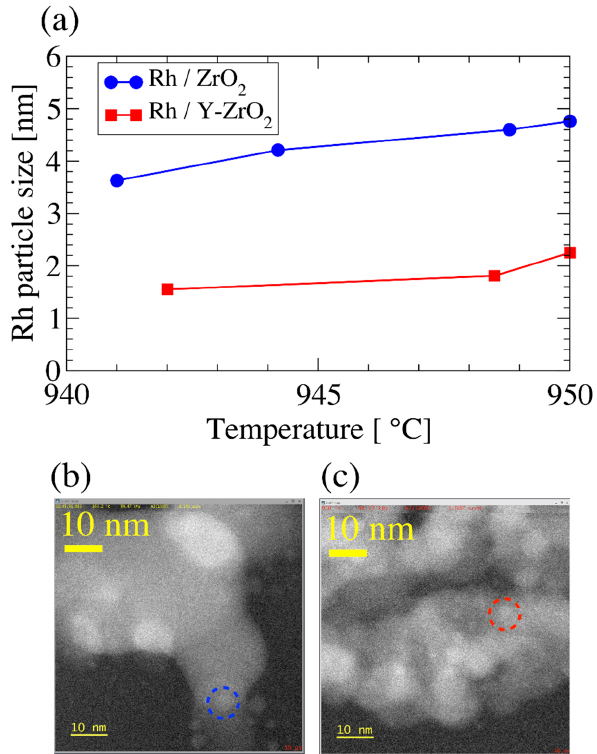
Figure 10. ( a ) Temperature dependence of the Rh particle size, which was obtained from tracking the corresponding Rh particle in the STEM images in Figures 8 and 9. ( b ) and ( c ) are STEM images of Rh/ZrO 2 and Rh/Y-ZrO 2 at 950 °C in N 2 gas. The size of the Rh particles within the dashed circle was evaluated.